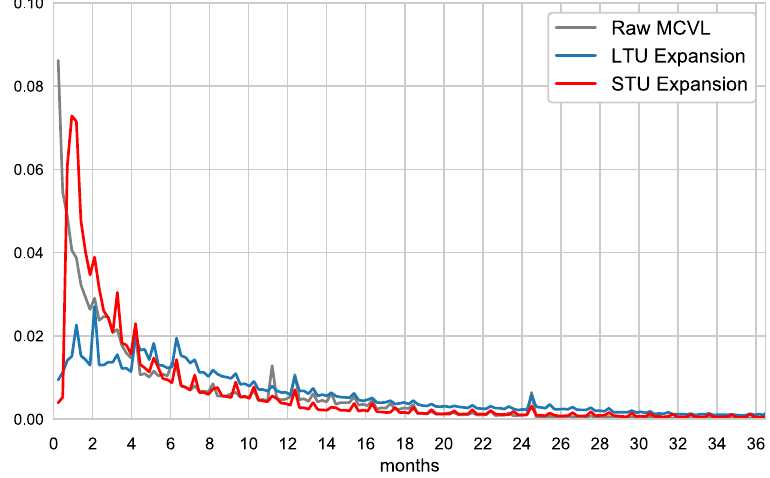
Fig.7 Histogram of spell duration, by expansion. Source : MCVL. Raw MCVL refers to spells not affected by either expansion, while LTU and STU expansion refer to spells affected by each expansion,